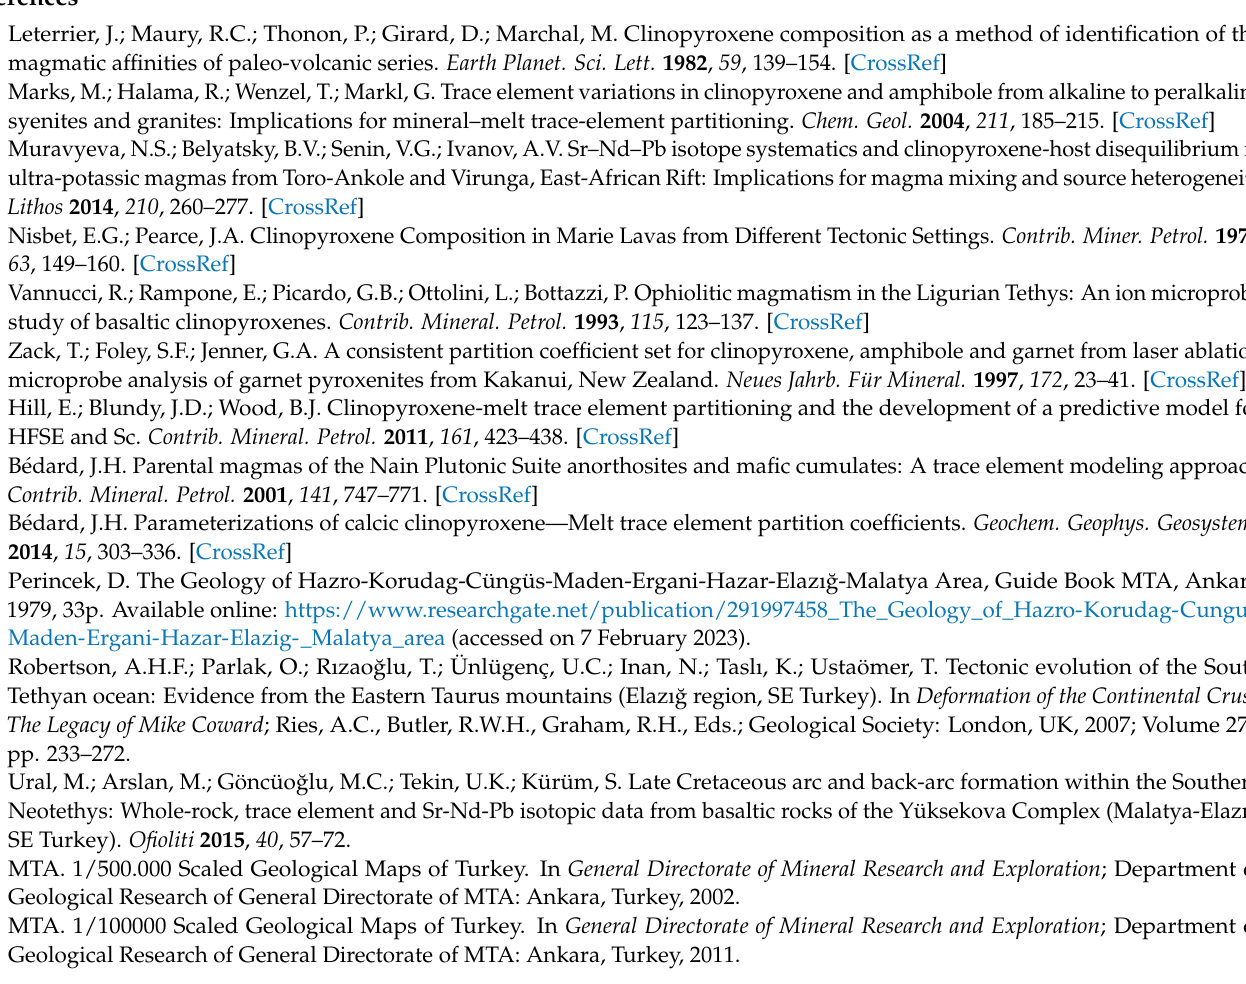
Figure S3: Primitive mantle normalized multi-element variation patterns of zoned clinopyroxene grains; Table S1: Electron microprobe analyses of clinopyroxenes; Table S2: Trace element composi- tions of clinopyroxenes; Table S3: Calculated melt compositions in equilibrium with